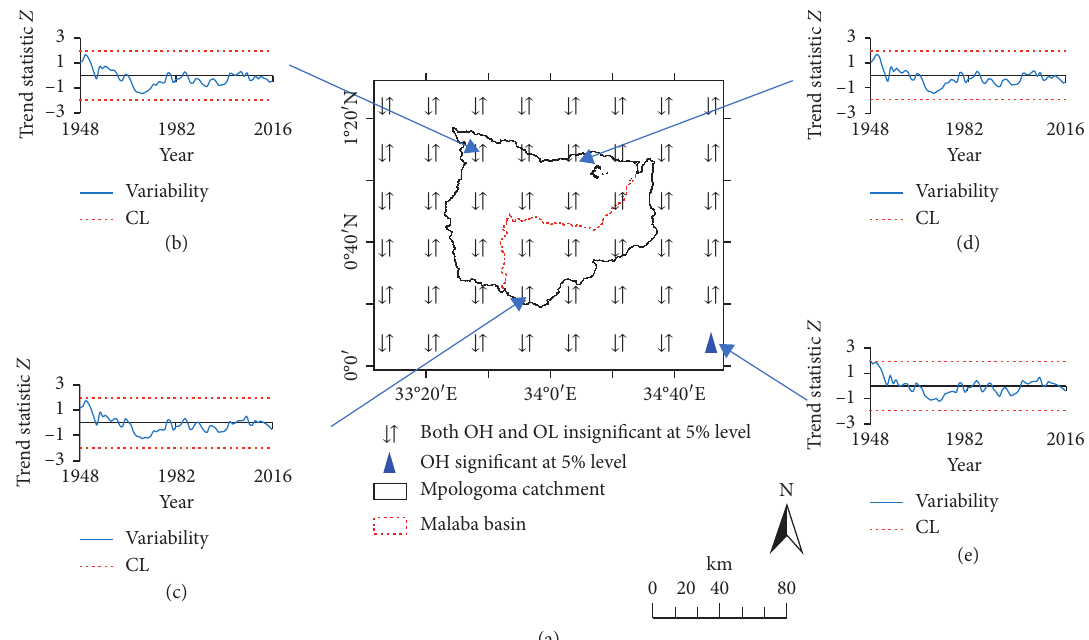
Figure 5: Spatial differences in the significance of rainfall variability (a) and temporal variability in JJAS rainfall (b–e) at different locations of the study area.